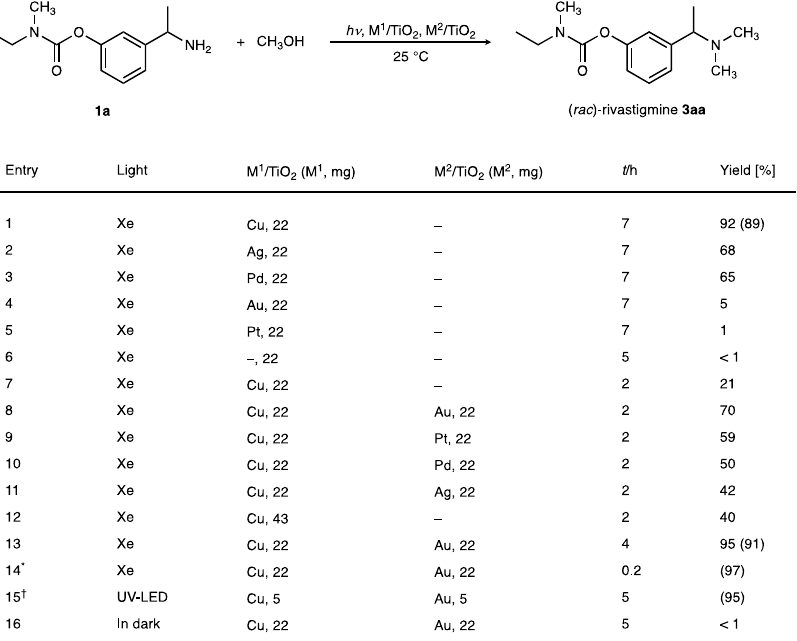
Figure 2. Light-induced dimethylation of 1a with methanol leading to ( rac )-rivastigmine ( 3aa ). Typical conditions (entry 1): 1a (1.0 mmol), Cu/TiO 2 (22 mg), CH 3 OH (10 mL, 250 mmol, 250 equiv), 300 W Xe lamp with a UV-cold mirror ( λ = 300–470 nm), Ar (1 atm), 25 °C. Metal content in 22 mg photocatalysts: Cu/ TiO 2 (5 wt% Cu, 16 µ mol Cu), Au/TiO 2 (5 wt% Au, 5.1 µ mol Au), Pt/TiO 2 (5 wt% Pt, 3.2 µ mol Pt), Pd/TiO 2 (5 wt% Pd, 9.5 µ mol Pd), and Ag/TiO 2 (4 wt% Ag, 8.5 µ mol Ag) as determined by ICP-AES. Yields of 3aa were determined by GC/MS or 1 H NMR using 2,2-dimethylpropan-1-ol as an internal standard. Isolated yields are in parentheses. * Conditions: 1a (50 µ mol), CH 3 OH (5 mL), 50 °C. † Conditions: 1a (0.2 mmol), CH 3 OH (2 mL), 32 W UV-LED lamp ( λ 0 = 365